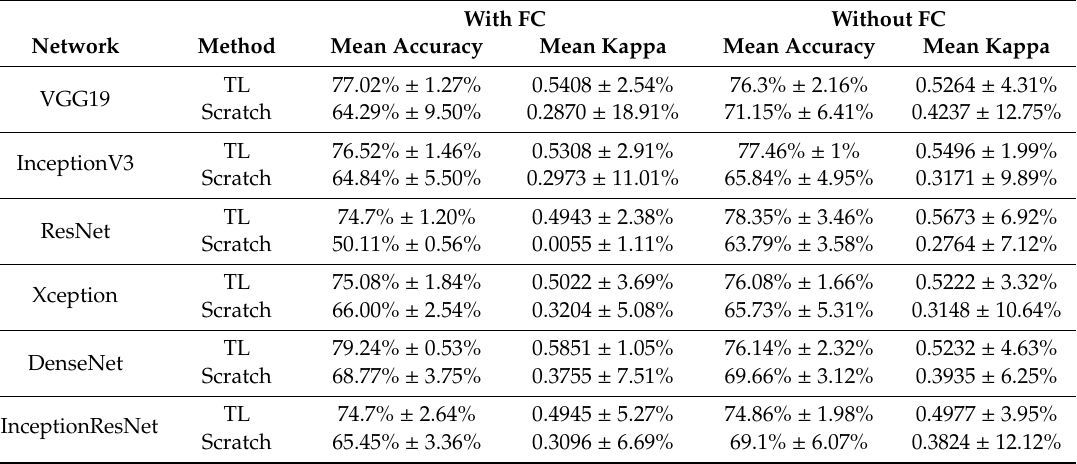
Table 9. Accuracy and Kappa scores of classifying shoulder images with and without fully connected layers ( ± 95%